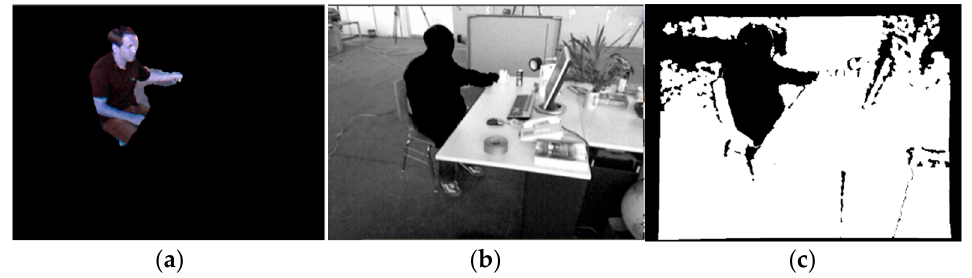
Figure 2. Based on the camera pose corresponding to the previous frame, the dynamic object mask is projected from the dynamic object database, and the dynamic object part in the current frame is removed. ( a ) Final dynamic object mask; ( b ) dynamic part culling in intensity image; ( c ) dynamic part culling in depth image.